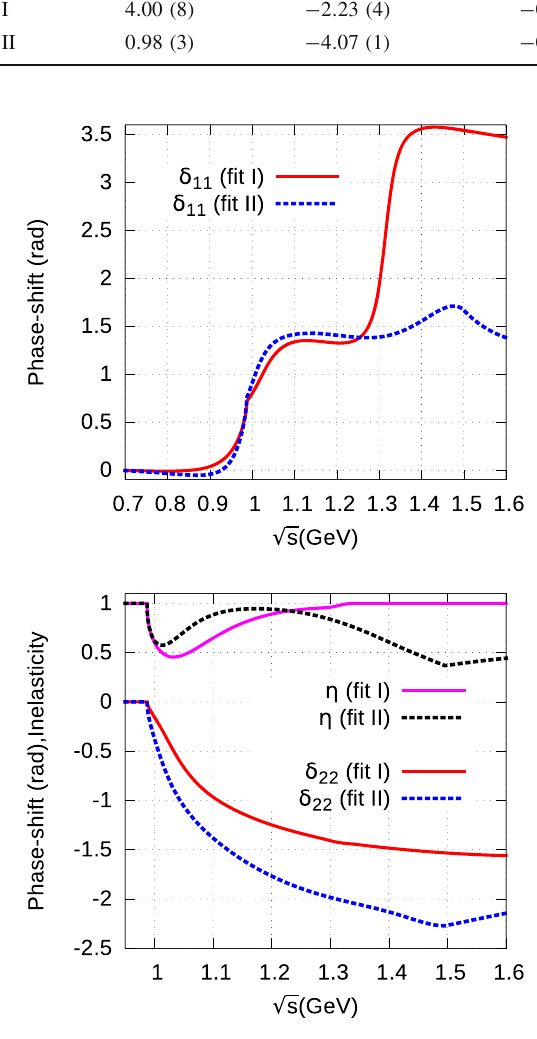
Fig. 5 The phase-shifts and the inelasticity from the two-channel T - matrix model using the two sets of parameters corresponding to the two χ 2